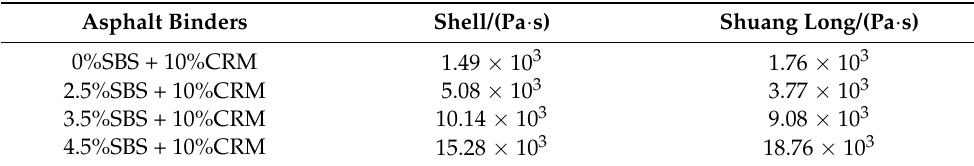
Table 5. ZSV values of hybrid modified asphalt binders (fixed CRM and various SBS). Asphalt